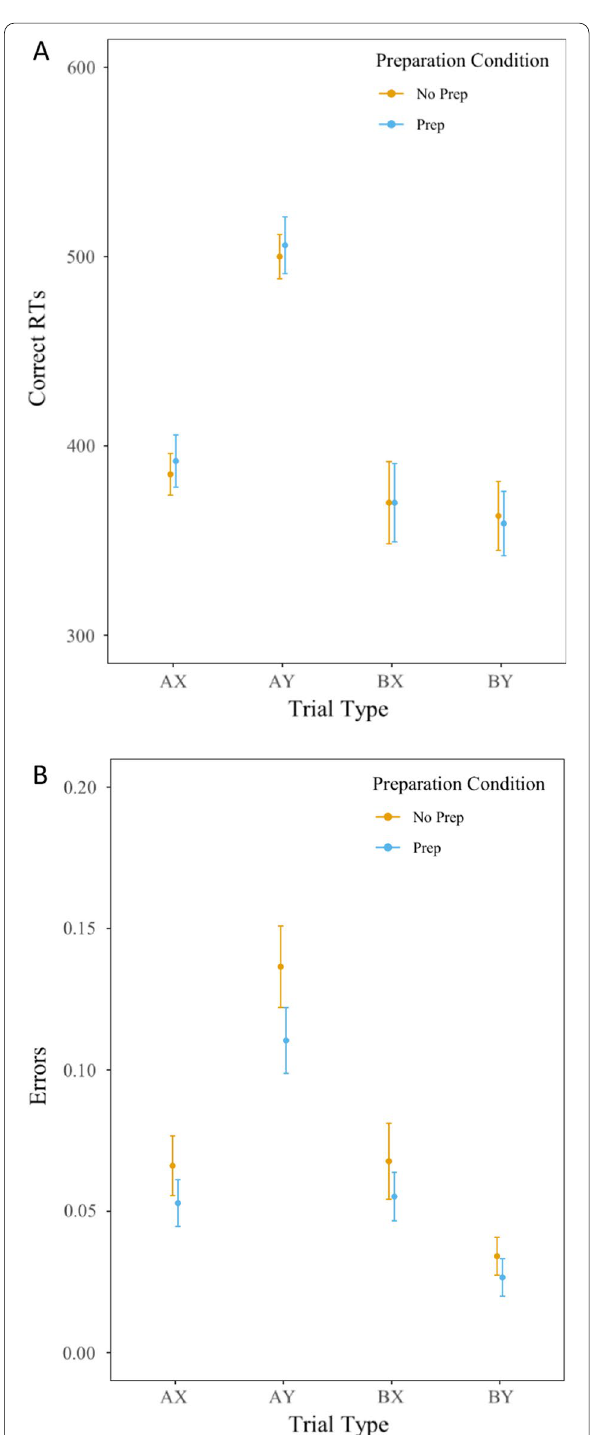
Fig. 4 Average median correct response times (ms) ( A ) and error rates ( B ) in the AX-CPT as a function of AX-CPT trial type and preparation condition (Prep or No Prep) in the Registered Experiment. Error bars standard error of the mean =